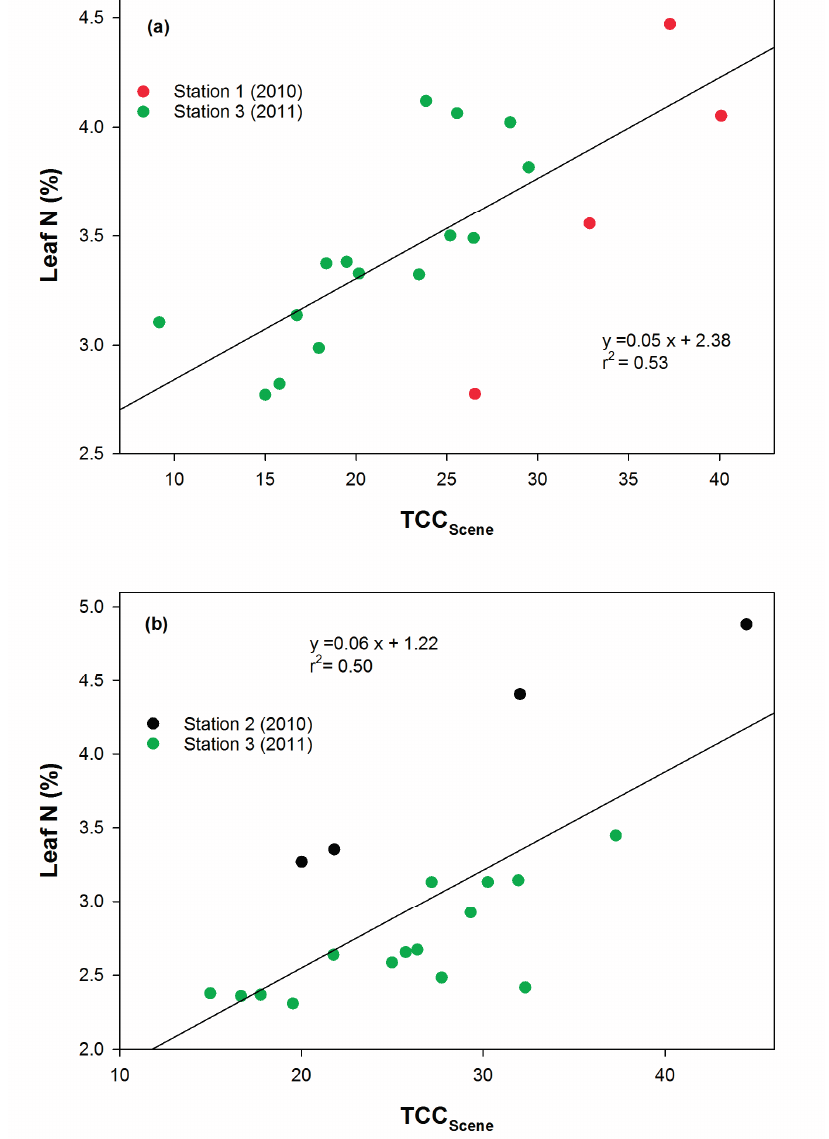
Figure 7. Linear regression between TCC Scene and leaf N at ( a ) mid to late squaring, and ( b ) early